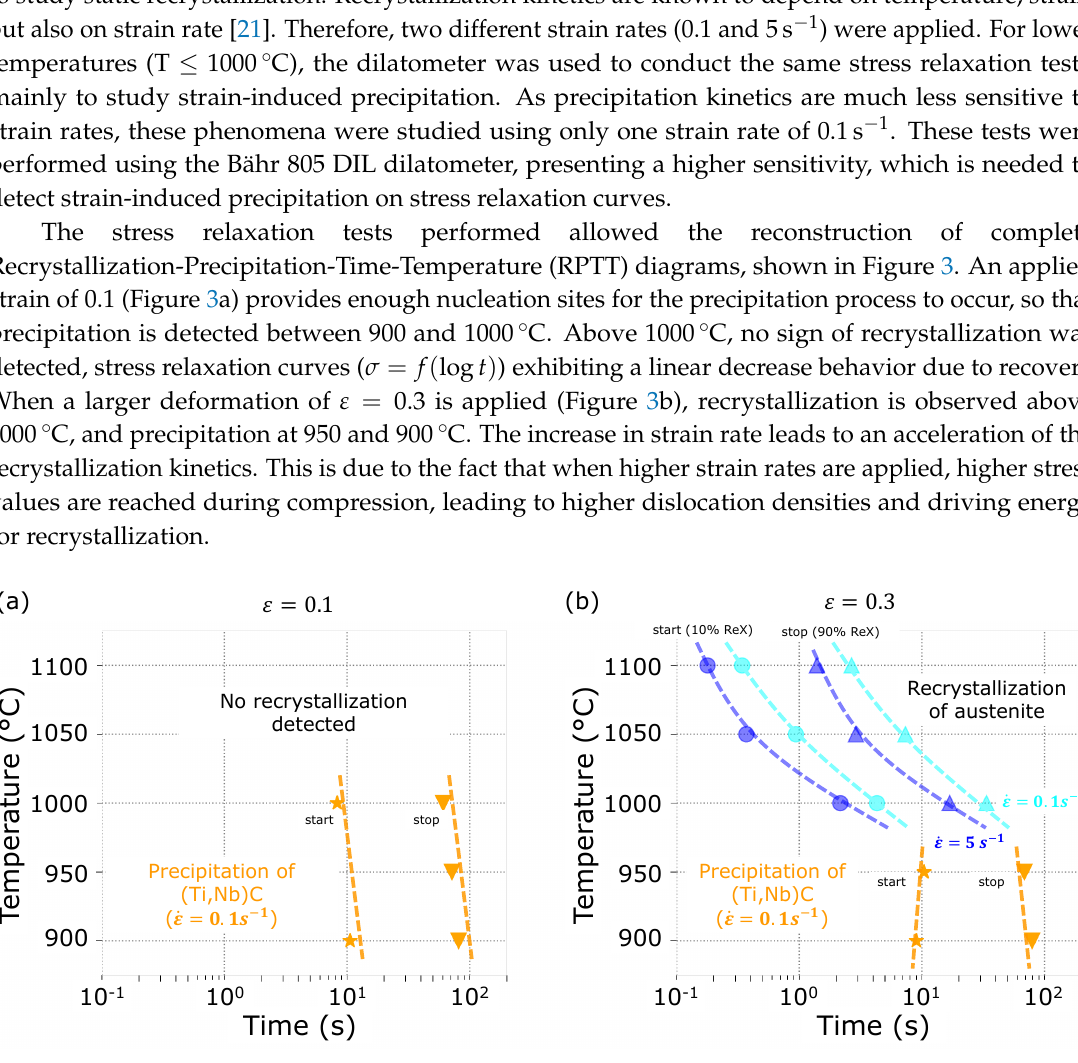
Figure 3. ( a , b ) Recrystallization-Precipitation-Time-Temperature (RPTT) diagram determined by stress relaxation